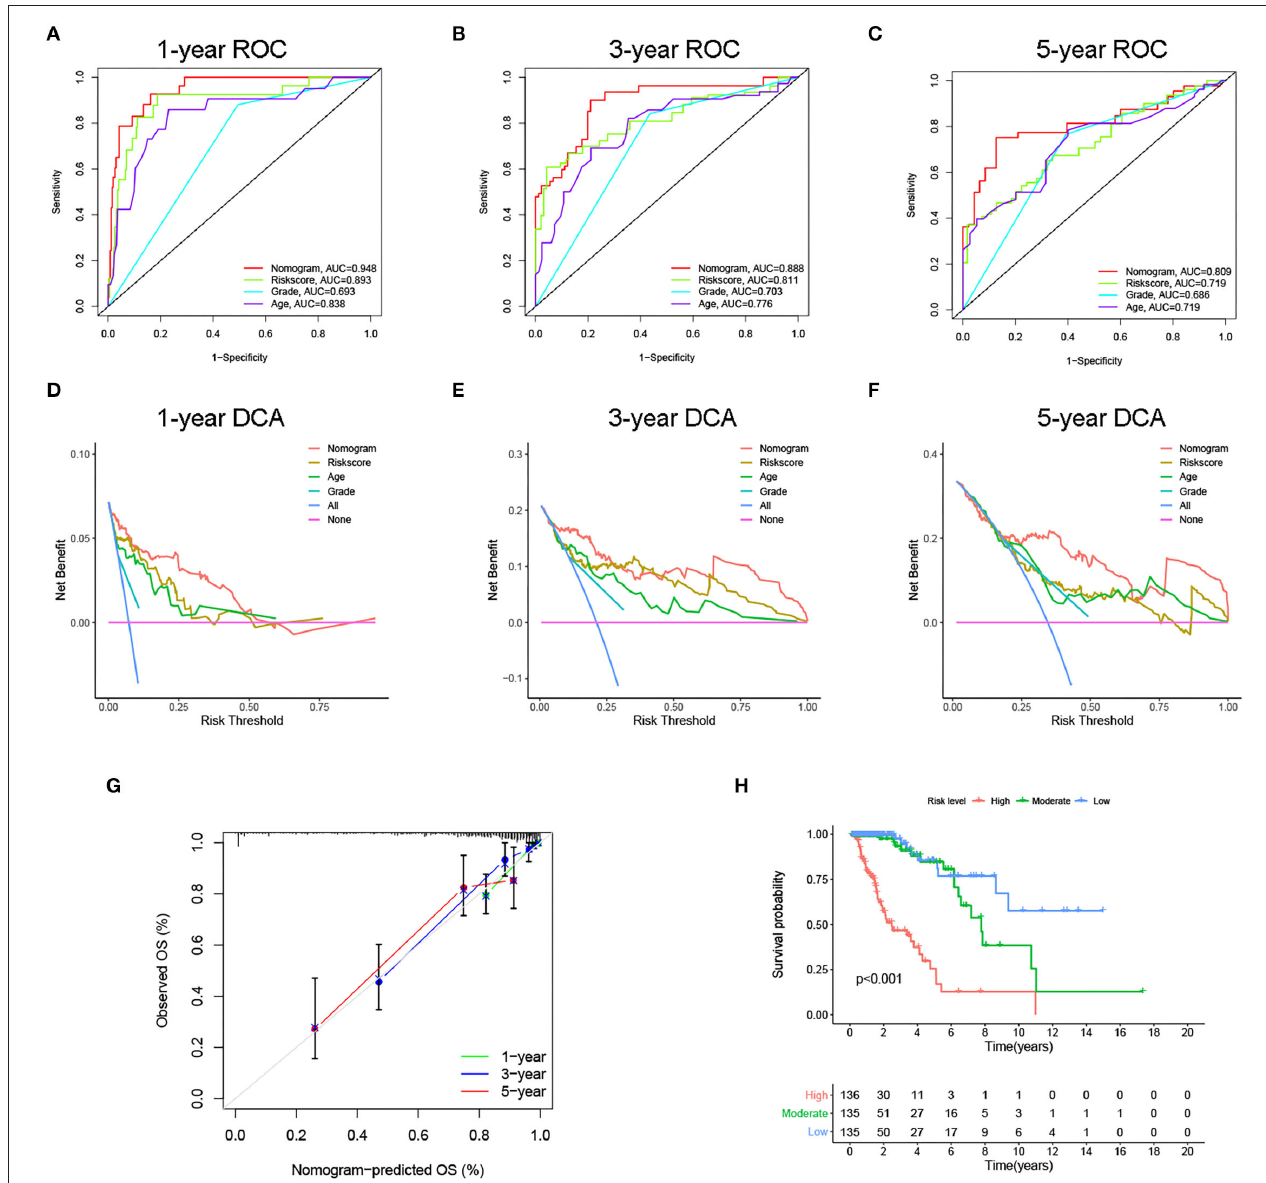
FIGURE 7 | Internal evaluation of the nomogram model. (A–C) Time-dependent ROC curves, (D–F) decision curve analyses (DCAs) and (G) calibration curves for 1-, 3-, and 5-year overall survival (OS) prediction of the nomogram. (H) Kaplan–Meier curve of the three subgroups based on the nomogram.